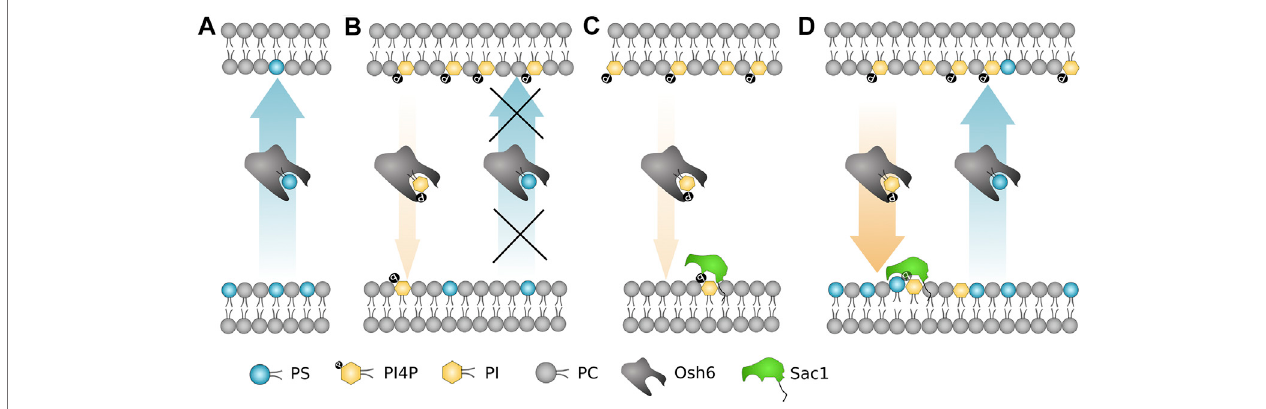
FIGURE 7 | Schematic summary of the most important biophysical determinants for the Osh6 transport. (A) PS is transported along the gradient spontaneously. (B) IfPI4PispresentinthePS-acceptingmembrane,Osh6bindingpocketisoccupiedbyPI4PandPStransportisinhibited. (C) Sac1failstodephosphorylatePI4Pifno negatively charged lipid is present in the PI4P-acceptor membrane. (D) Both the PS and PI4P transports are occurring if the PI4P release to the acceptor membrane is synchronized with the Sac1 action, which is subjected to the PS (or PI, PG) presence in the acceptor